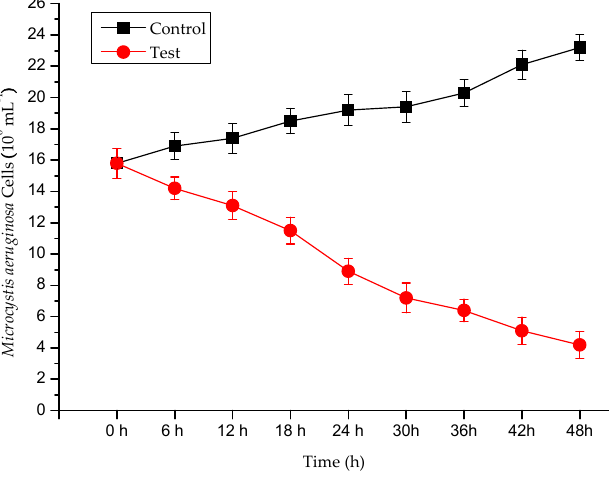
Figure 2. The growth curves of M. aeruginosa Cells of P. chrysosporium : M. aeruginosa alone and M. aeruginosa treated by P. chrysosporium . Data are expressed as the mean ± SD ( n = 3).